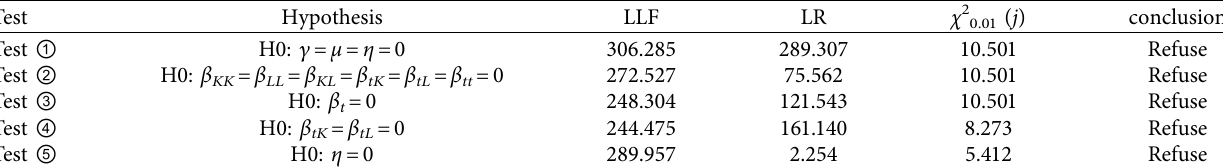
Table 1: Test result of model